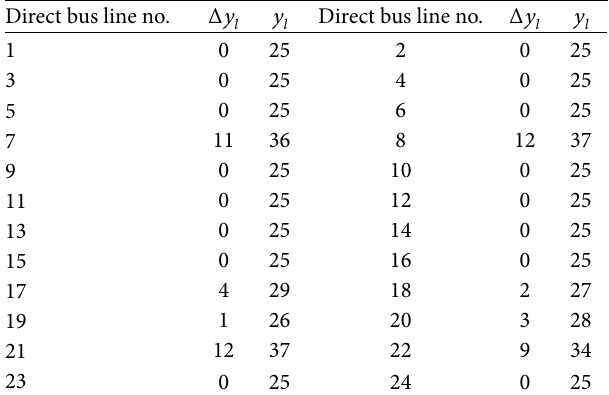
Table 6: Total passengers and saturation on some . 𝑥 = 1.2